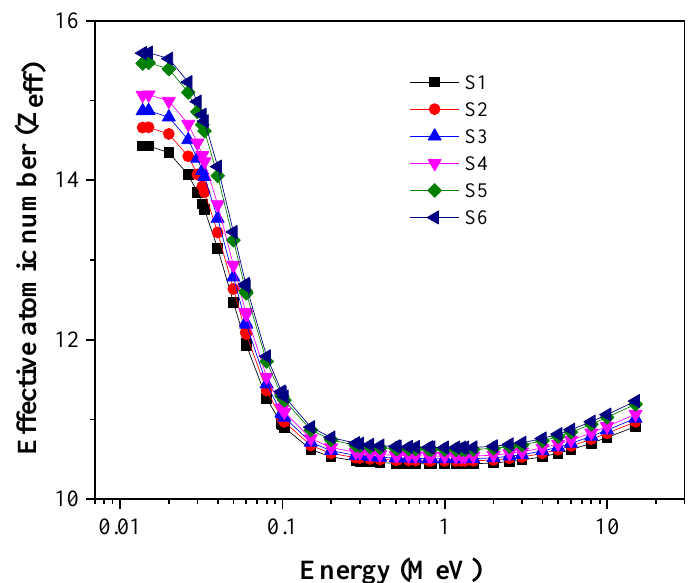
Figure 10. Change in Z eff as a function of gamma-photon energy.